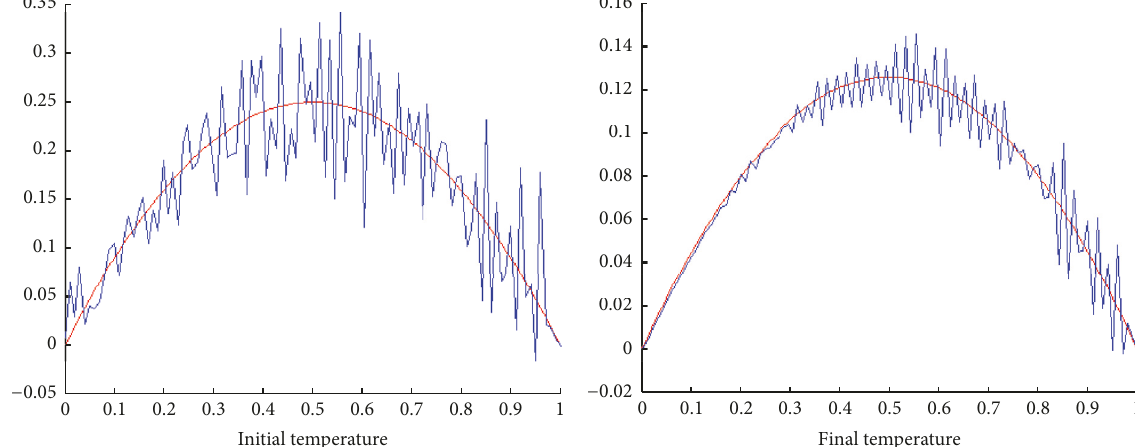
Figure 21: This figure shows that we cannot rebuild the solution.